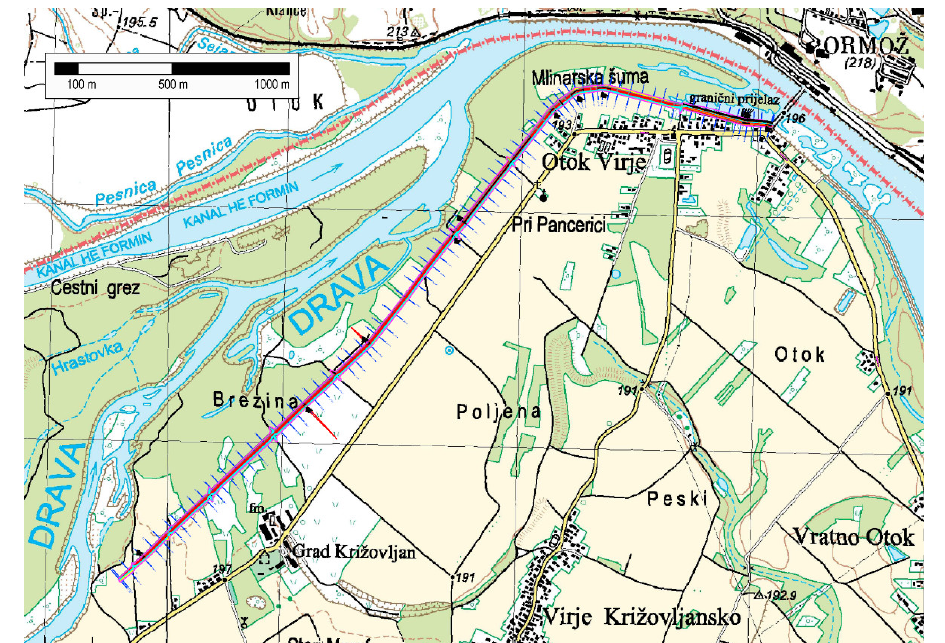
Figure 5. Situational view of levee section.